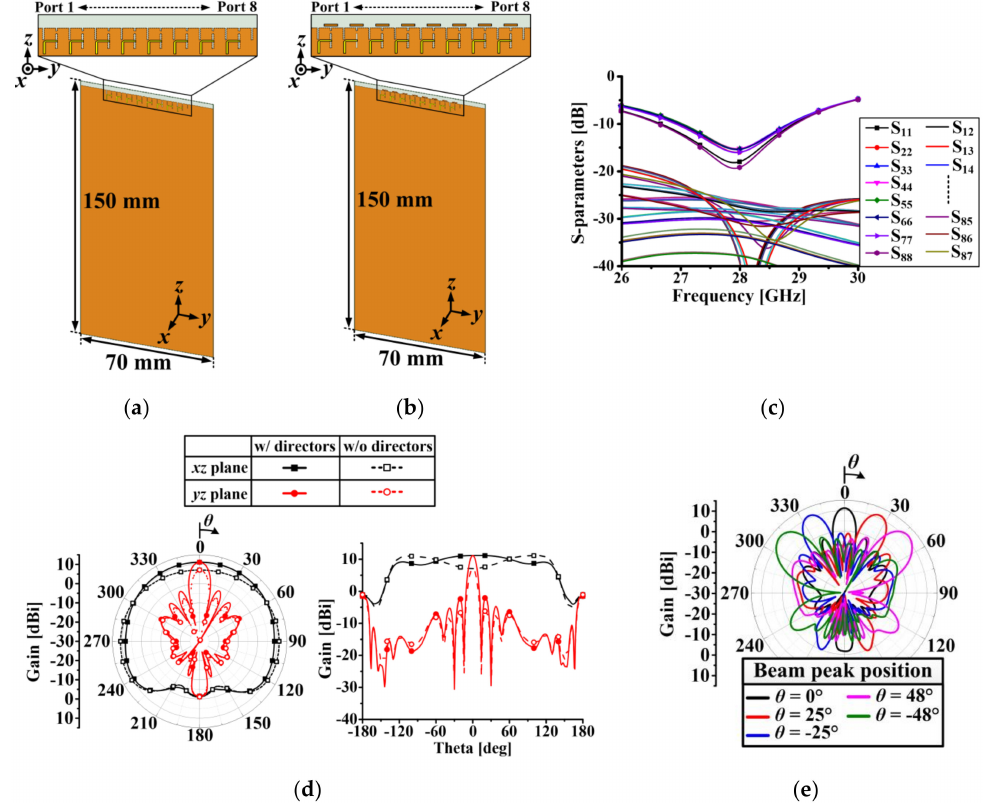
Figure 13. The 1 × 8 array antenna: ( a ) without directors, ( b ) with directors, ( c ) with simulated S-parameters with directors, ( d ) showing simulated radiation patterns at 28 GHz, and ( e ) showing simulated beam steering performances in the yz plane at 28 GHz, with